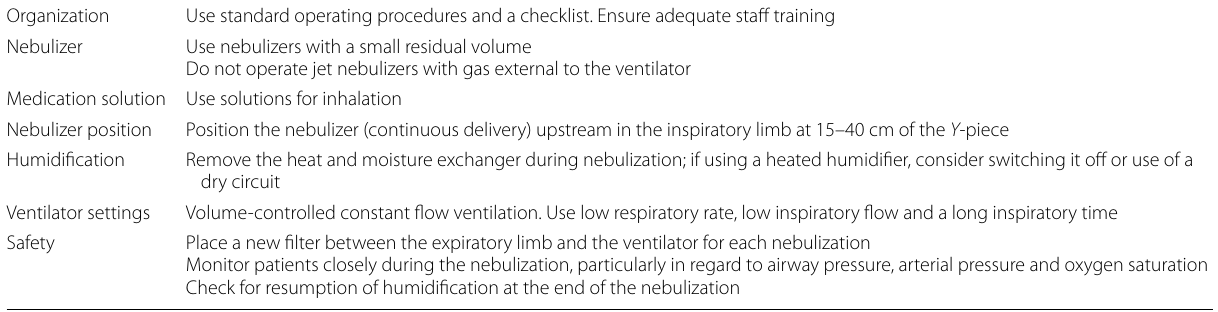
Table 3 Key good practices for optimal antibiotic nebulization during mechanical ventilation Organization